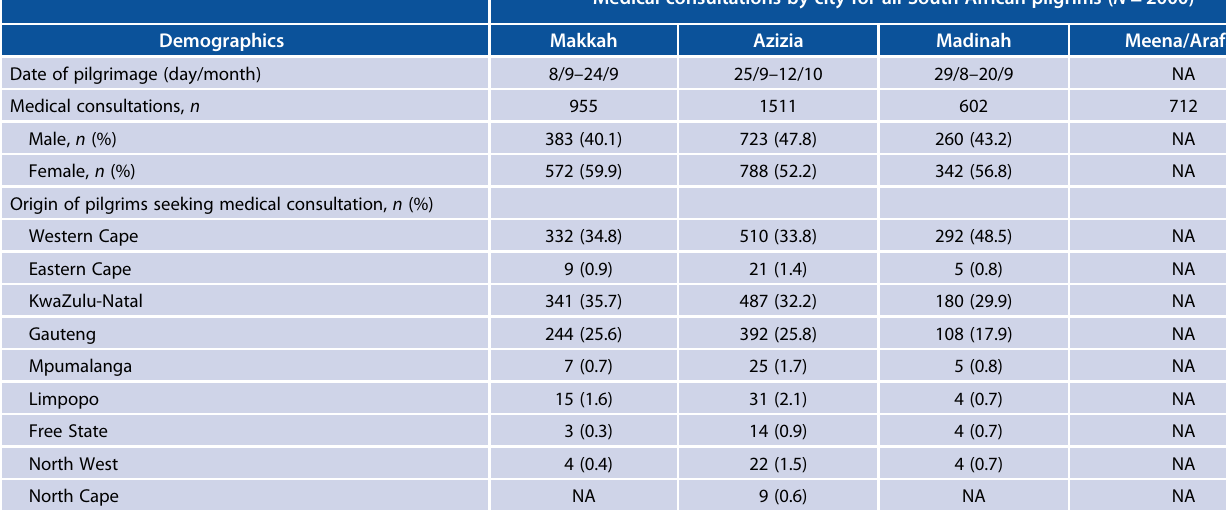
Table 1: Demographics of South African pilgrims requiring medical consultations during the 2014 Hajj